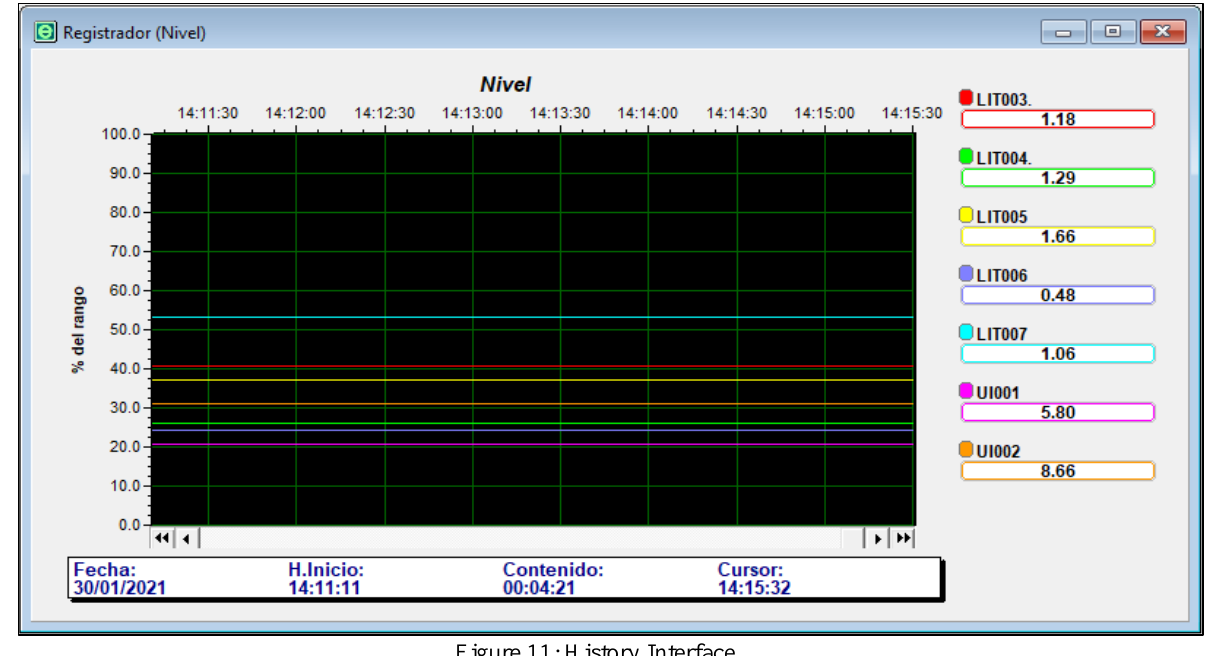
Figure 11: History